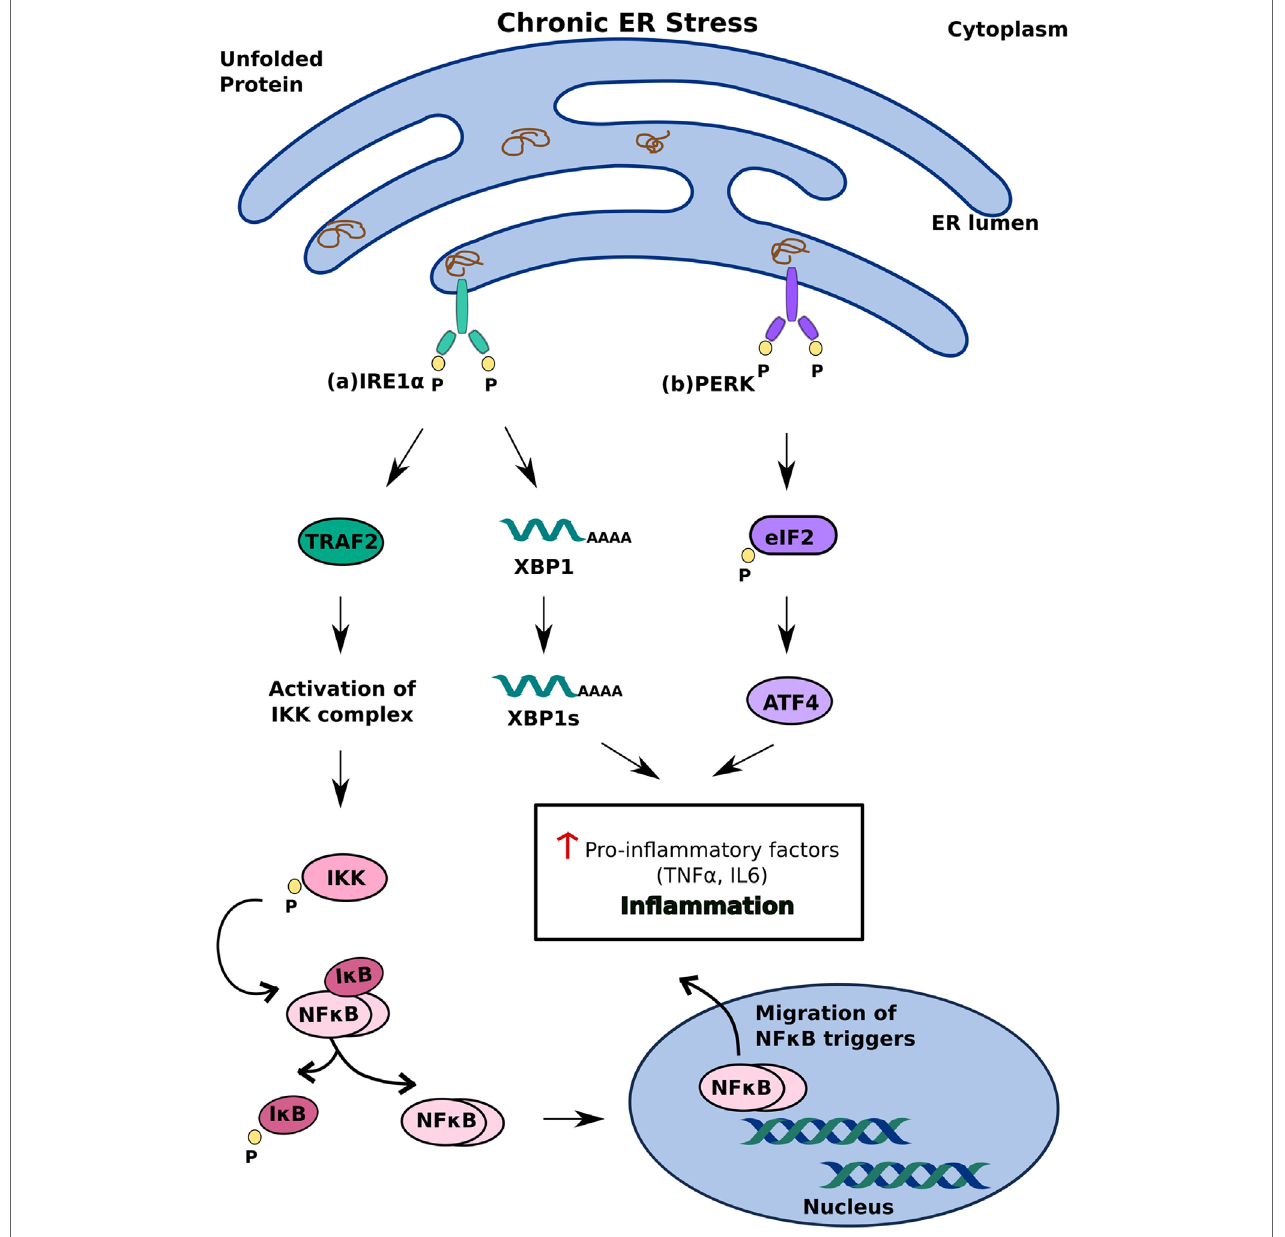
FigURe 3 | Inflammatory unfolded protein response (UPR) response under chronic endoplasmic reticulum (ER) stress. ER stress triggers apoptosis through activation of inflammation. This can be achieved (A) inositol-requiring 1 α -mediated stimulation of IKK complex or XBP1s and (B) PERK-mediated activating transcription factor 4 activation. These induce release of pro-inflammatory factors which enhances cell